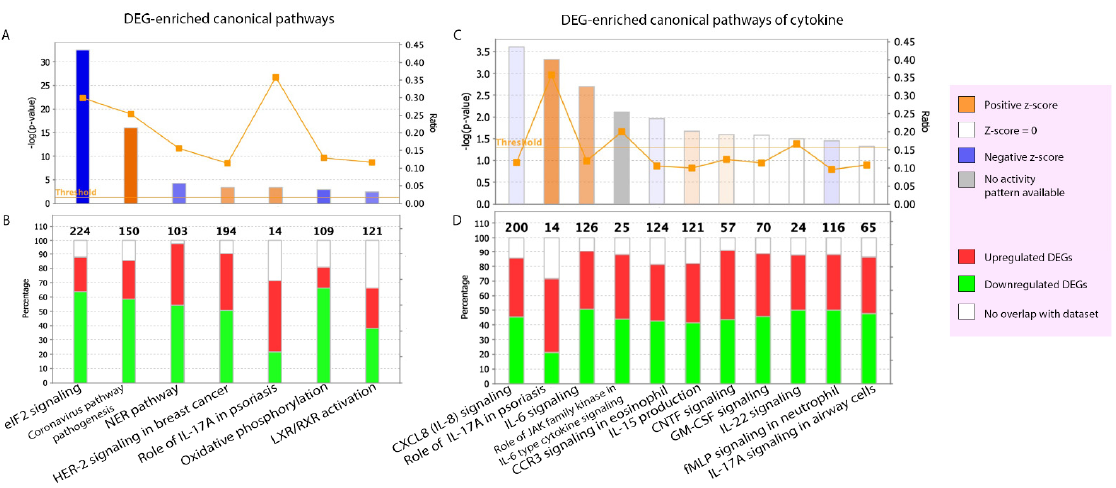
Figure 4. DEG-enriched canonical pathways. ( A , C ) The height of the bar represents the level of significance. The predicted activation pathways are shown by orange bars and the predicted inhibition pathways are shown by blue bars. The more intense the color, the stronger the activity prediction. The orange line connecting square points in each bar indicates the ratio of the dataset DEGs that are members of each known pathway divided by the total molecules’ pathway. ( B , D ) Percentage of DEGs overlapping in each pathway. Percentage of the non-overlapped pathway’s molecules is shown by the white segment of the bar. The total number of molecules in each canonical pathway are shown on the top of the bar. CCR3, C-C Motif Chemokine Receptor 3; CNTF, ciliary neurotrophic factor; CXCL8, C-X-C Motif Chemokine Ligand 8; DEG, differentially expressed gene; eIF2, eukaryotic initiation factor 2; fMLP, formyl-methionyl-leucyl-phenylalanine; GM-CSF, granulocyte-macrophage colony-stimulating factor; HER-2, human epidermal growth factor receptor; IL, interleukin; JAK, Janus Kinase; LXR/RXR, liver X receptor/retinoid X receptor; NER, Nucleotide excision repair.